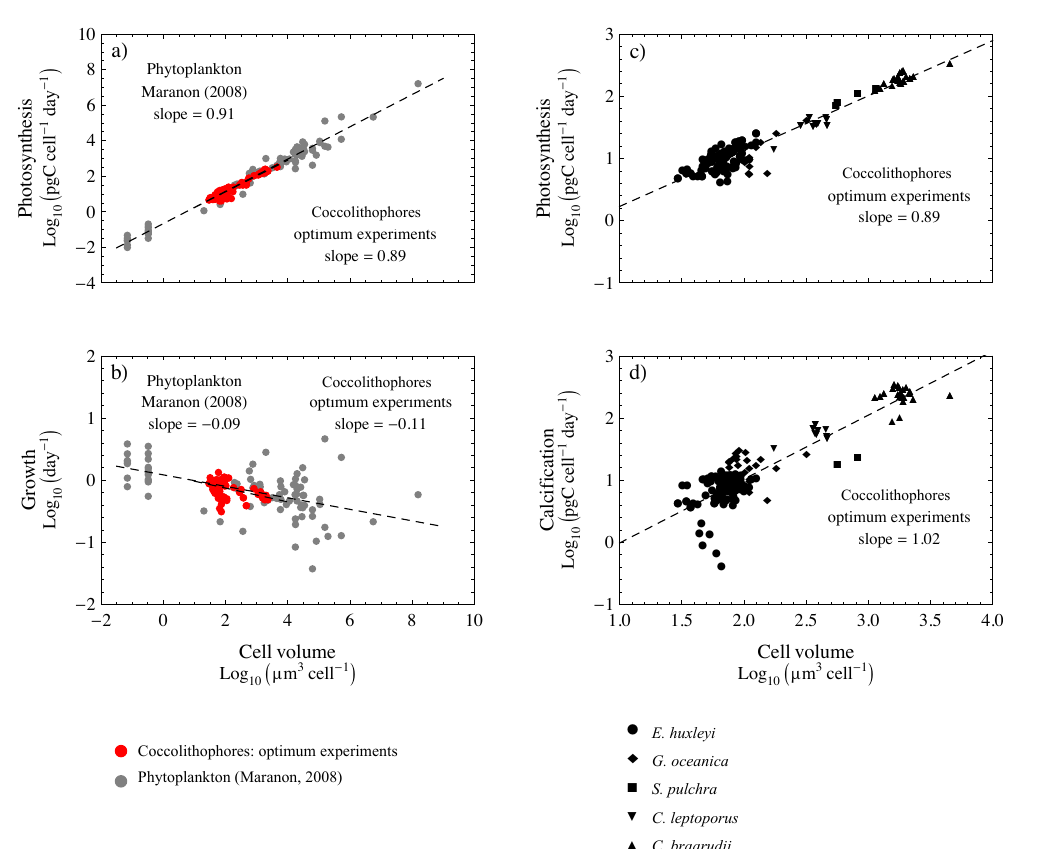
Figure 3. Allometric relationships between cell volume (Eq. 7) and photosynthesis rate ( a , c ; Eq. 5), growth rate ( b ; Eq. 3) and calcification rate ( d ; Eq. 6). Notes: in panels (a) and (b) red dots are the experiments from the coccolithophore database carried out in optimum growth conditions and grey dots are published field measurements of metabolic rates for a large number of organisms (Marañón, 2008); in panels (c) and (d) symbols denote coccolithophore species (see legend) and all data refer to optimum growth conditions. The dotted lines are the linear regressions through the experimental coccolithophore data obtained in optimum growth conditions and the field data of Marañón (2008; see Table 2 for definition of optimum growth